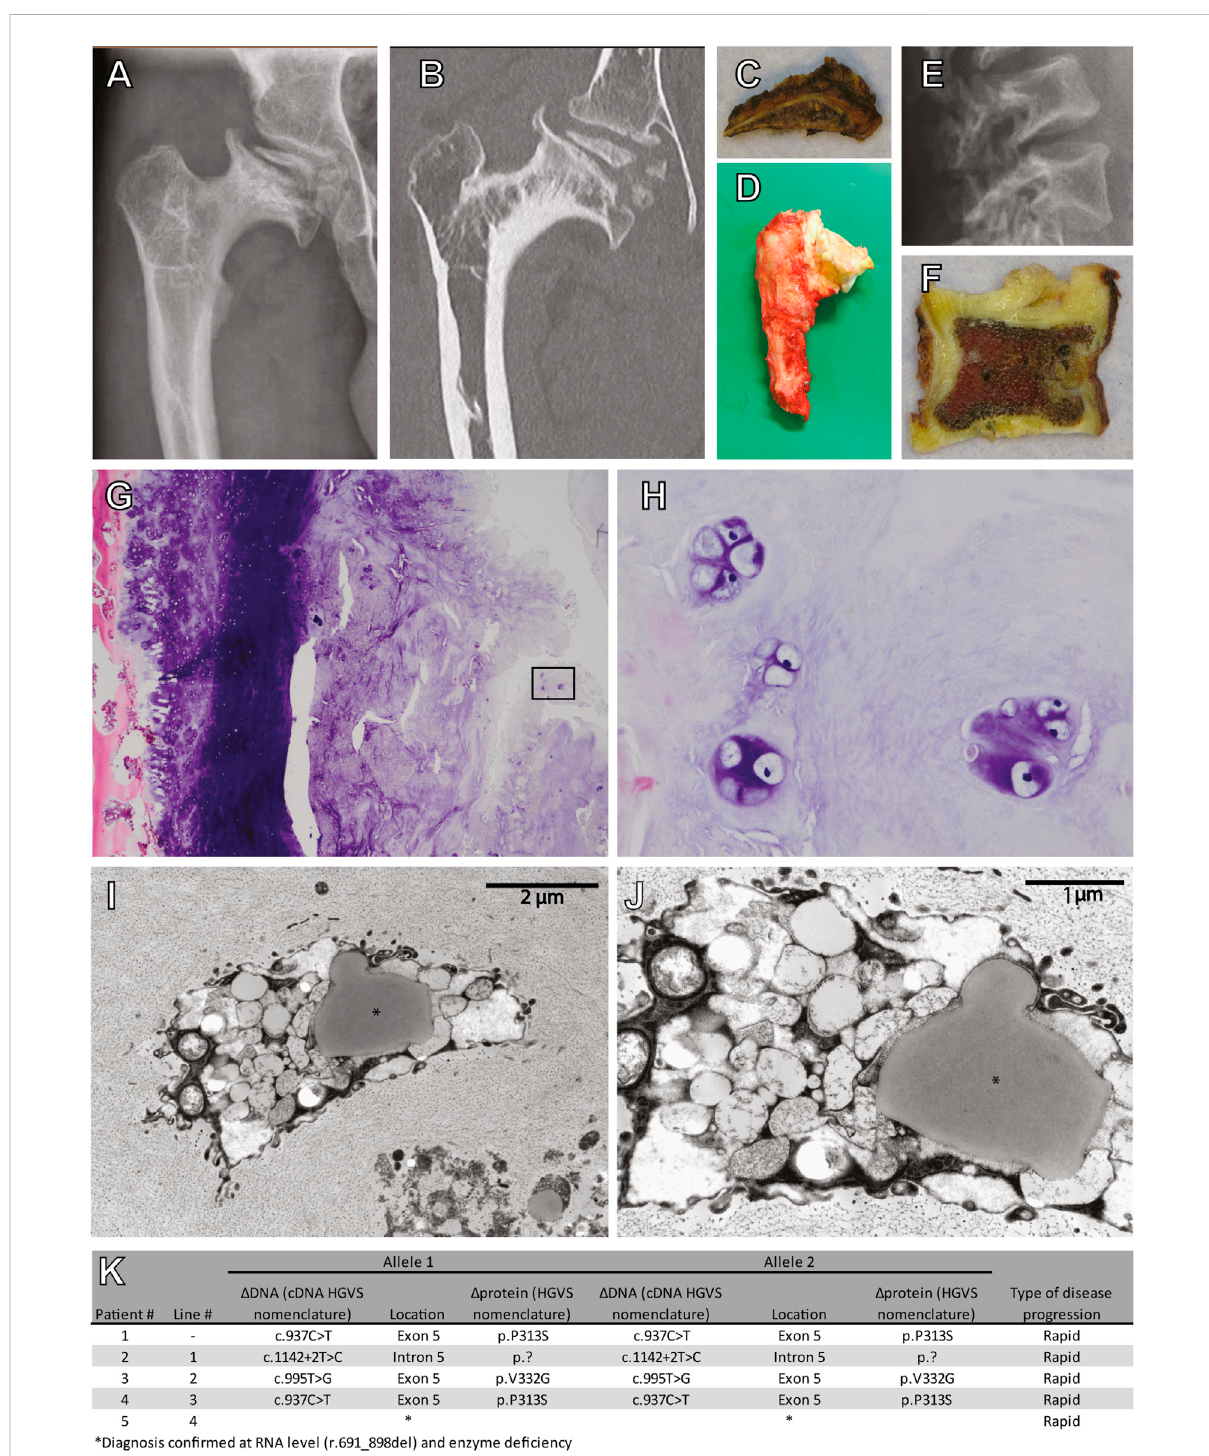
FIGURE 1 Cartilagepathologyina25 yearolddiseasedMPSVIpatient. (A) X-rayand (B) CTscanoftherighthip.Macroscopicpicturesfromautopsyofthe (C) right acetabulum and (D) femoral head. (E) X-ray ofthelumbar vertebrae. (F) A macroscopicpicture from autopsyof one vertebra. (G) HE stain of cartilage from this vertebra (Magni fi cation ×100), (H) details from the inset in G (Magni fi cation ×400). (I,J) Electron microscopy analysis showing examples of chondroyctes with different types of vacuoles and in addition lipid storage (indicated with *). (K) Characteristics of included